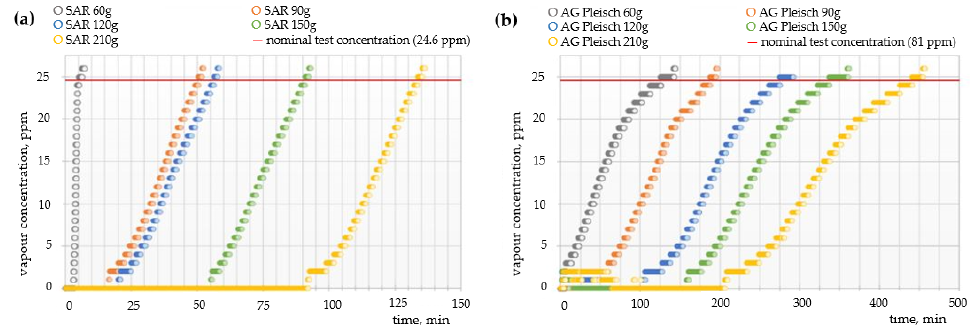
Figure 5. Breakthrough time curves of toluene vapors for filtration fabrics with different contents of ( a ) SAR and ( b ) AG Pleisch sorbents.